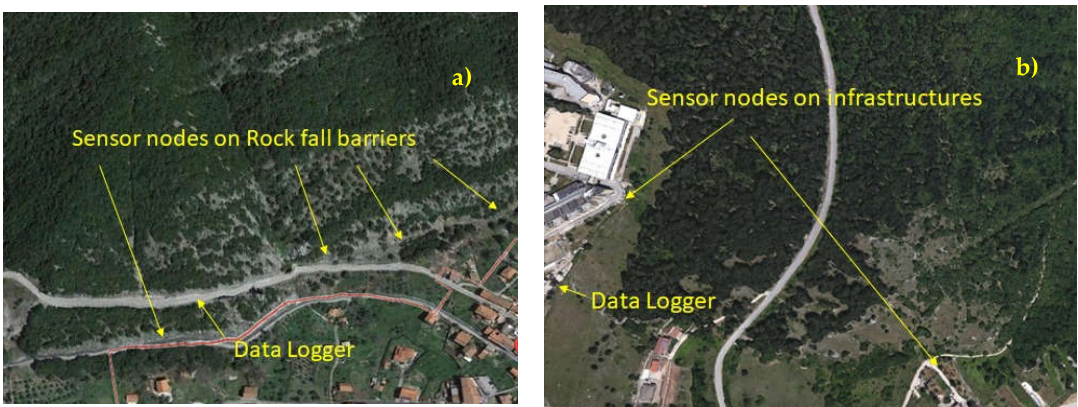
Figure 14. Example 1: ( a ) installation on rock fall barriers in the south of Italy; ( b ) installation on concrete buildings in the center of Italy.